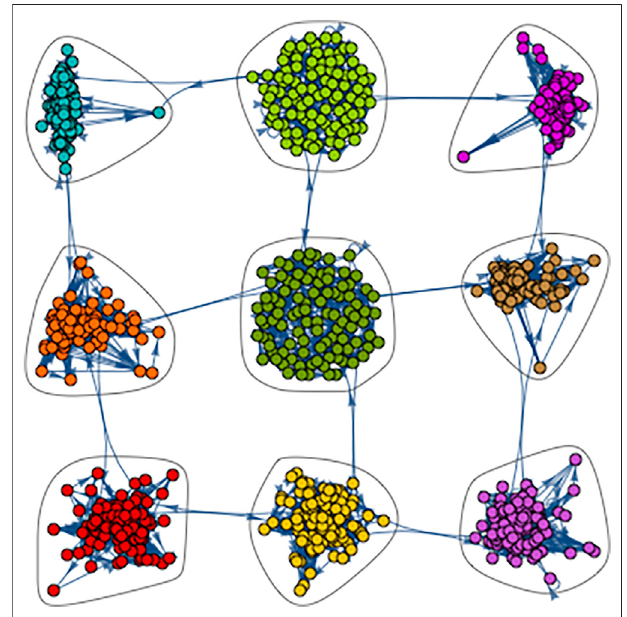
FIGURE 1 | An M × M grid of K -vertex modules (strongly connected sub-networks inside each bubble ) with ( K , M ) (cid:2) ( 100 , 3 ) and an average in and out degree z (cid:2) Q / K ≈ 3: the whole is strongly